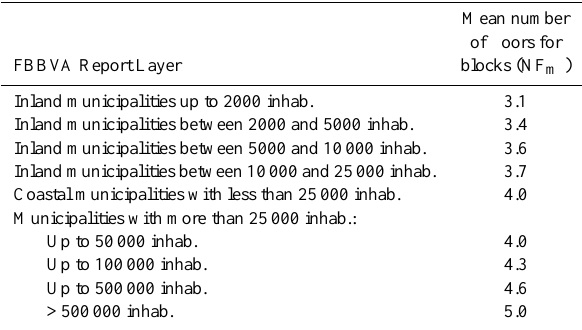
Mean number of floors for